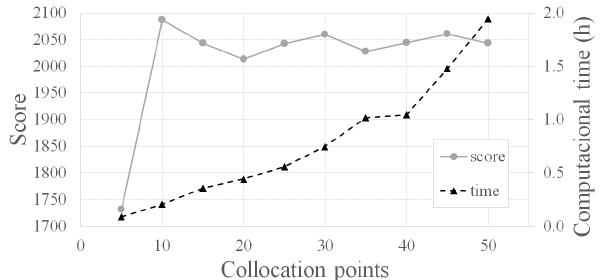
Figure 19. Trajectory collocation points study.